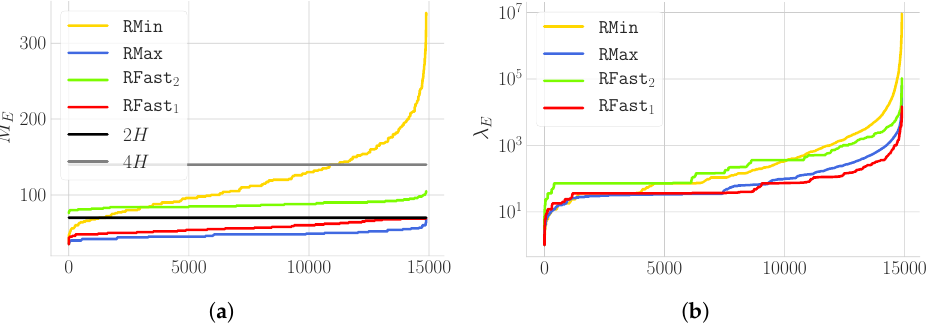
Figure 5. Distribution of values of: M ( E ) ( a ); and λ E ( b ) exhibited by all algorithms on instances induced by all partitions of H = 35. Instances are sorted by non-decreasing values of: M ( E ) ( a ); and λ E ( b ). To magnify the differences, the y -axis in ( b ) is